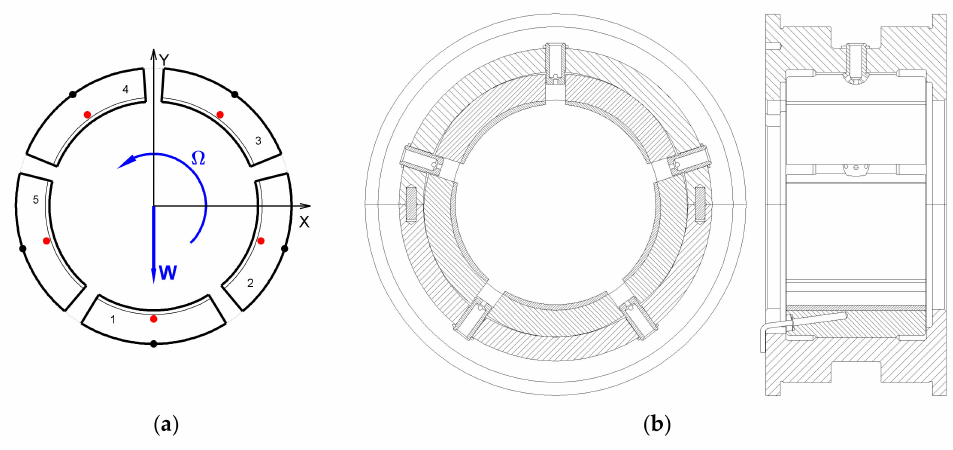
Figure 1. ( a ) Scheme and reference system of the bearing in nominal condition. Red dots represent the position of the temperature probe in each pad; ( b ) Actual drawings of the